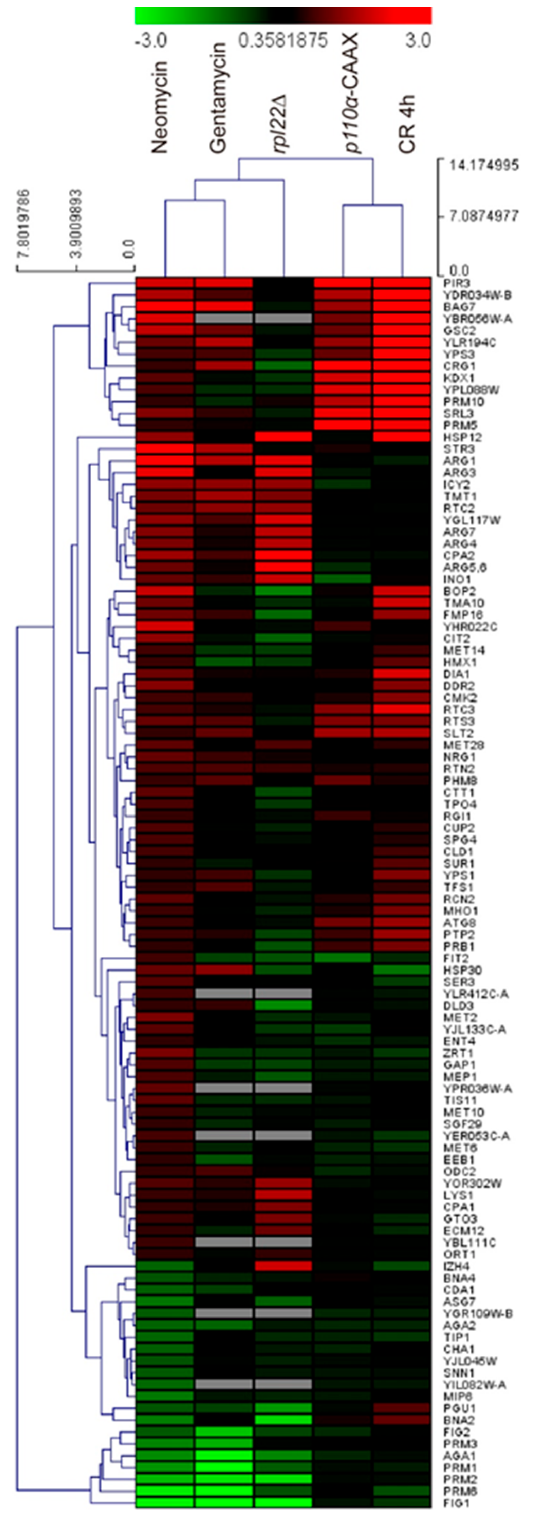
Figure 8. Comparison of the transcriptional profiles in response to neomycin, gentamycin (GEO Accession Number GDS2999), RPL22 deletion [39], Congo red (CR) exposure [23] and p110 α -CAAX overexpression [34]. Red colors are assigned to upregulated genes in each condition while green indicates downregulation. Hierarchical clustering using Euclidean distance was generated using the software Multi ‐ Experiment Viewer (MeV).